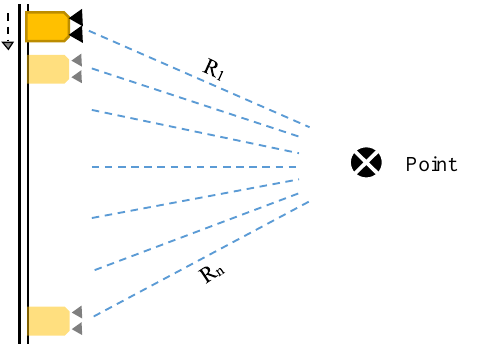
Figure 1. Different slant ranges in GB-SAR